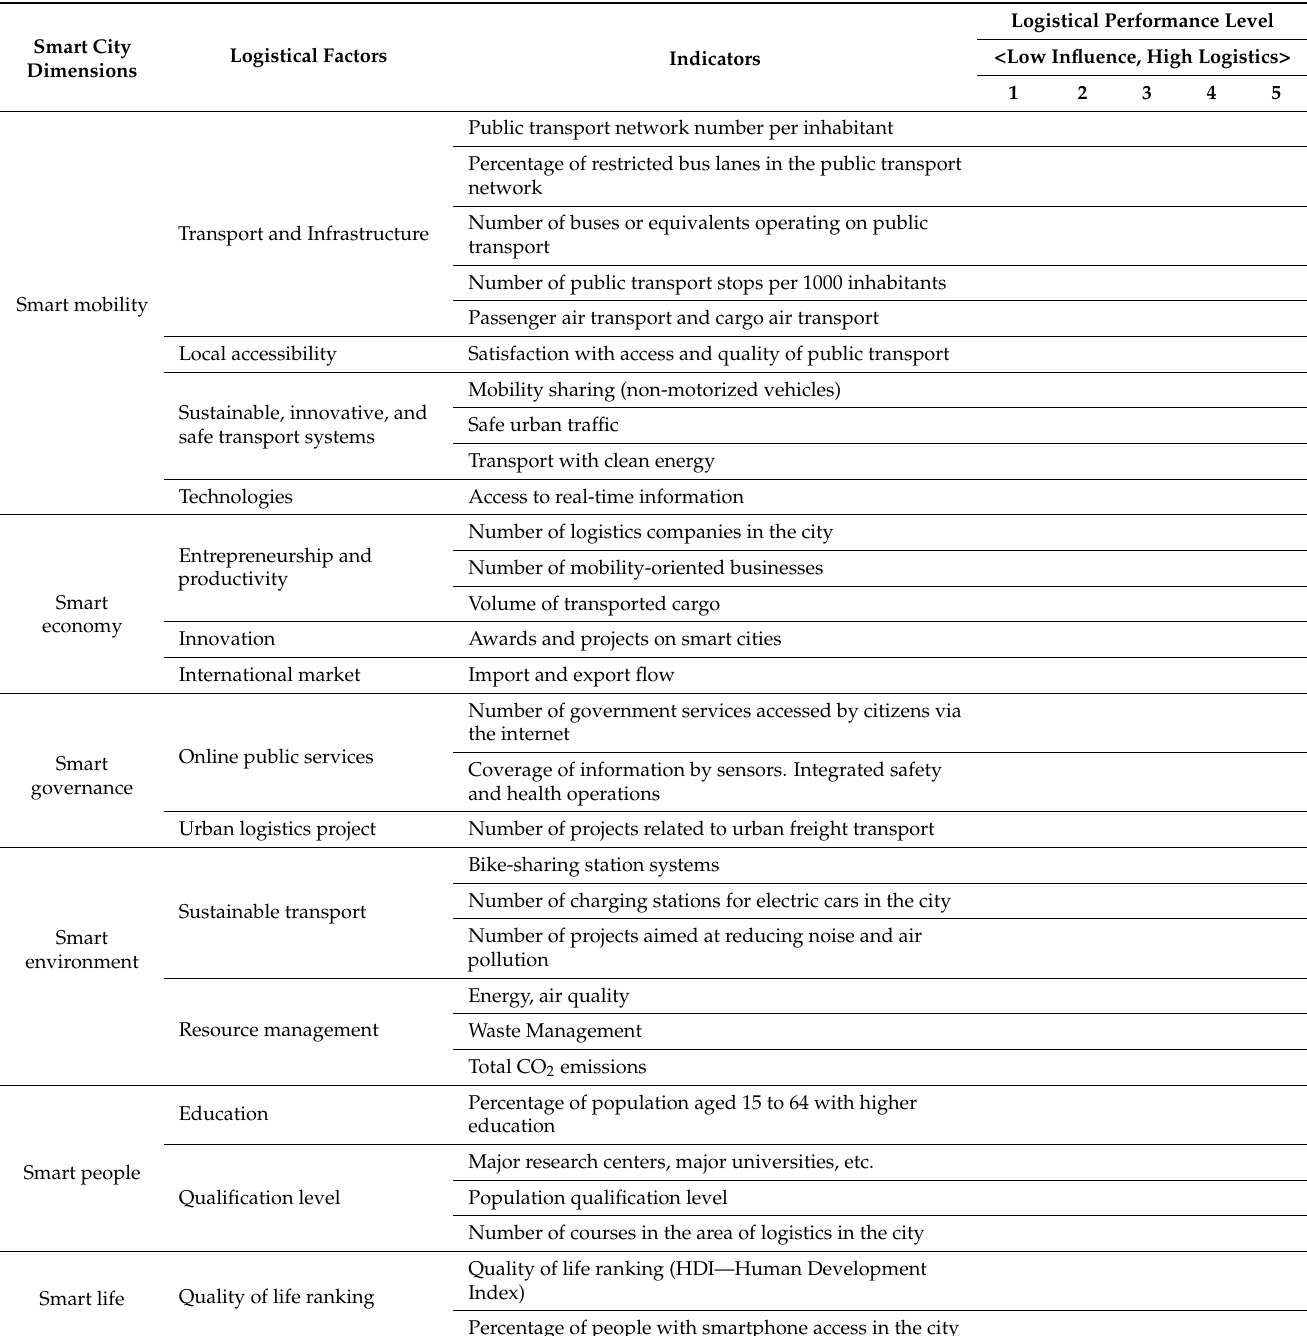
Table 4. The proposition of the conceptual model for evaluating the levels of logistics maturity in the dimensions of smart